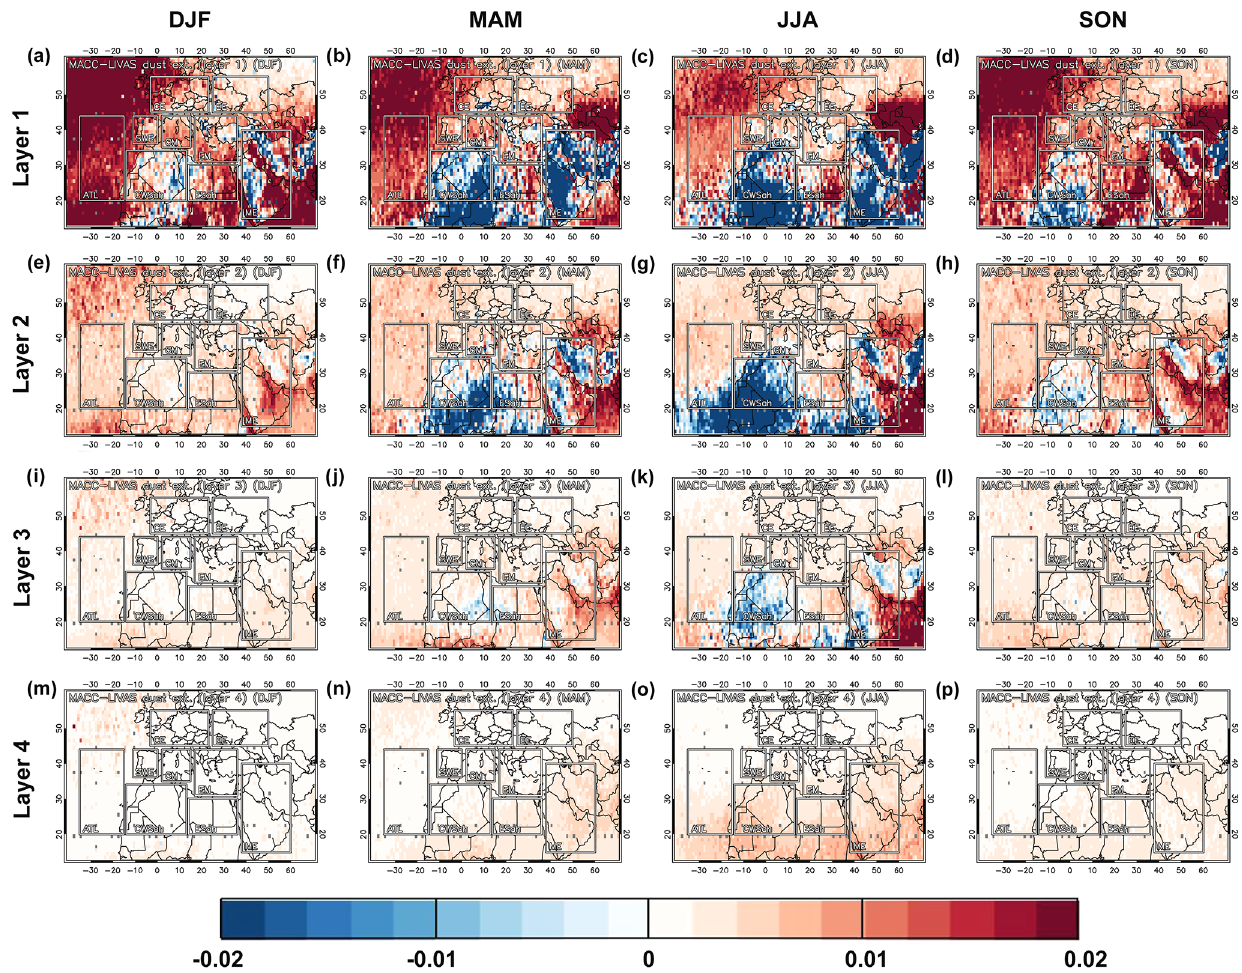
Figure 7. Seasonal patterns (DJF: column 1, MAM: column 2, JJA: column 3 and SON: column 4) of the mean bias between the MACC average dust extinction coefficient at 550nm (in km − 1 ) and the LIVAS average dust extinction coefficient at 532nm (in km − 1 ) over the Europe–northern Africa–Middle East domain for layer 1 (a, b, c, d) , layer 2 (e, f, g, h) , layer 3 (i, j, k, l) and layer 4 (m, n, o, p)